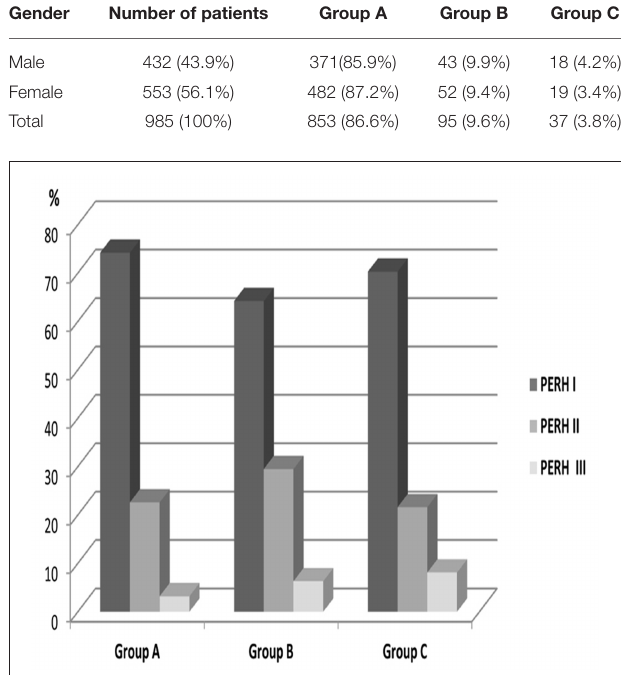
FIGURE 1 | Distribution of patients by PERH types frequency and the time of manifestation in the group A, B, C. PERH-I (disorganization of basic rhythm) is the first column, PERH-II (paroxysmal discharges) is second column, PERH-III (epileptic activity) is the third column. PERH-I was observed in the first, second and third minutes of HPT in all patients irrespective of age and sex. PERH-I was the predominant, compared to PERH- II and PERH- II was predominant, compared to